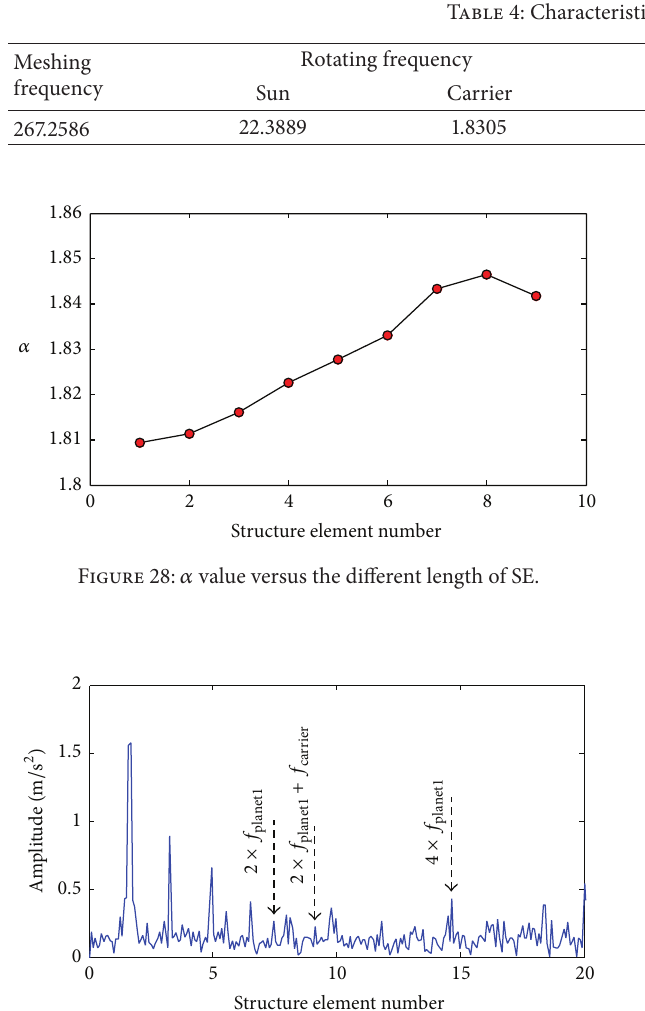
Figure 29: Frequency spectrum of filtered signal.